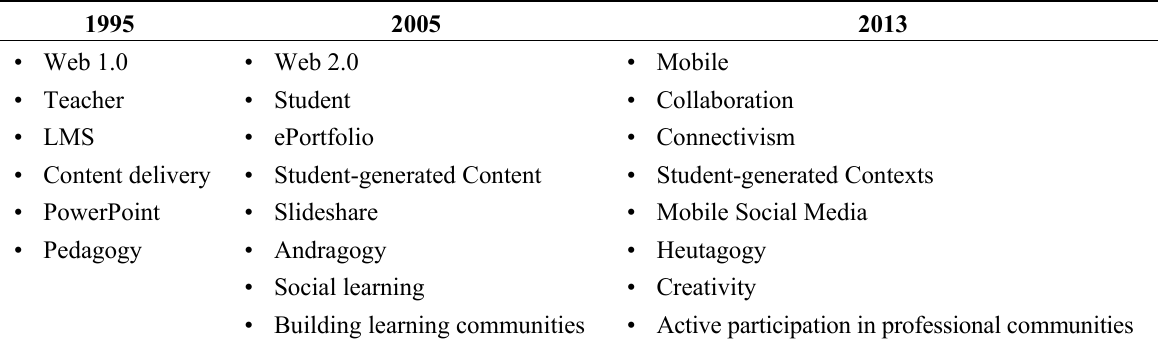
Table 2. Post Web 2.0